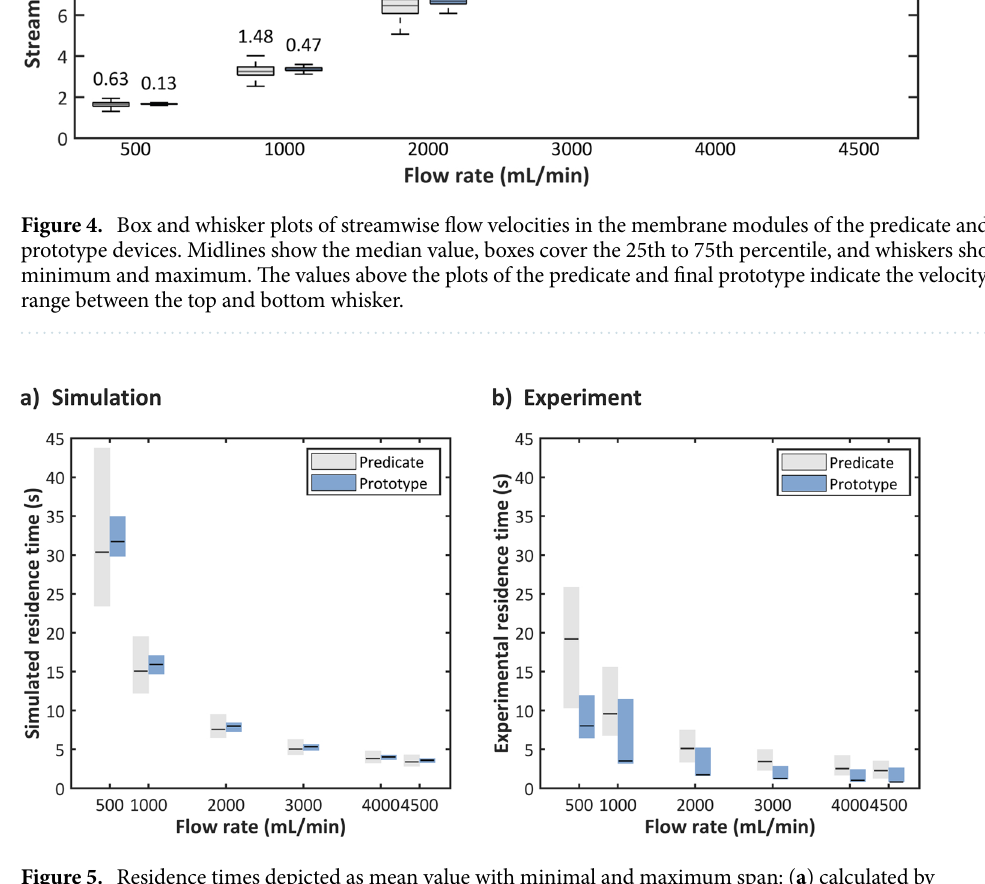
Figure 5. Residence times depicted as mean value with minimal and maximum span: ( a ) calculated by simulation and ( b ) measured in